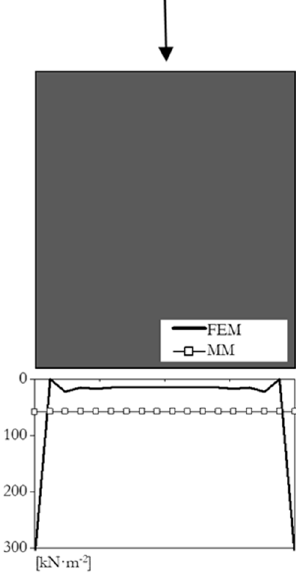
Figure 23. Pressures in the plane of symmetry, expressed in kN · m − 2 and determined by the Finite Element Model and the Matrix Model, on the base of the footing due to a 7.58 kN axial load and the footing self-weight.